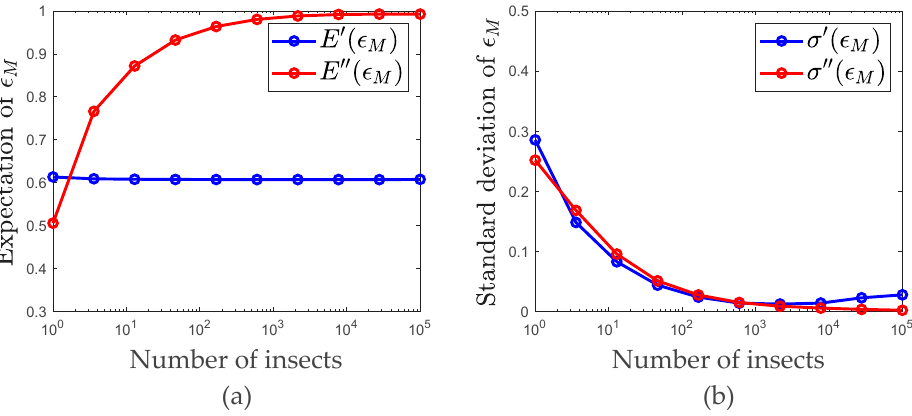
Figure 9. Comparison of the simulation results of ε M : ( a ) expectation of ε M ; ( b ) standard deviation of ε M .